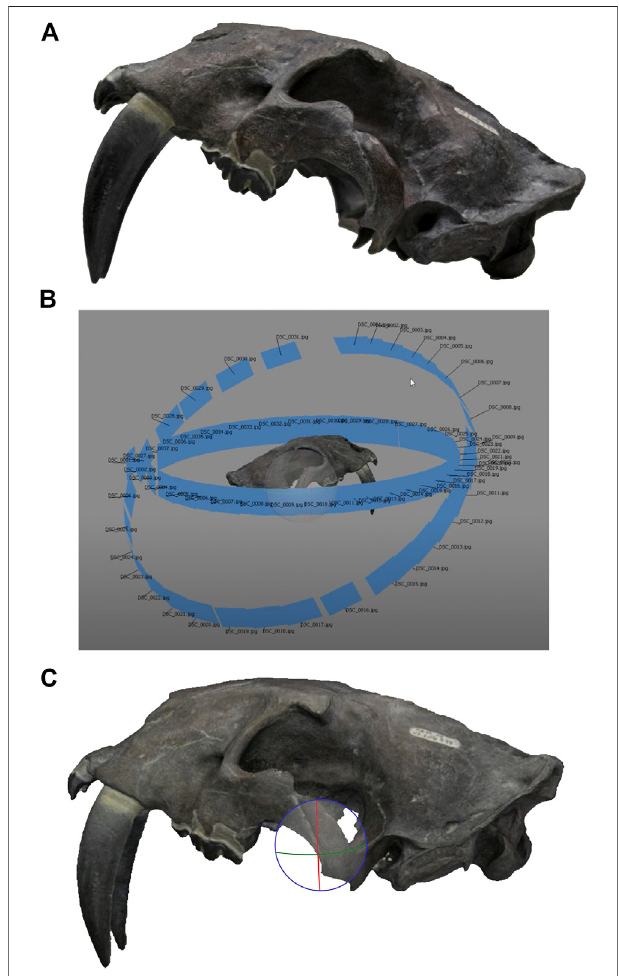
FIGURE3|(A) Photoimageofa Smilodongracilis skull(UF-VP-206593) from the FLMNH (B) Agisoft Photoscan software displaying the orientation and number of digital photos taken around the fossil specimen after processing the raw 3D data (C) Photogrammetric model of the fossil specimen ready to be shared digitally or 3D